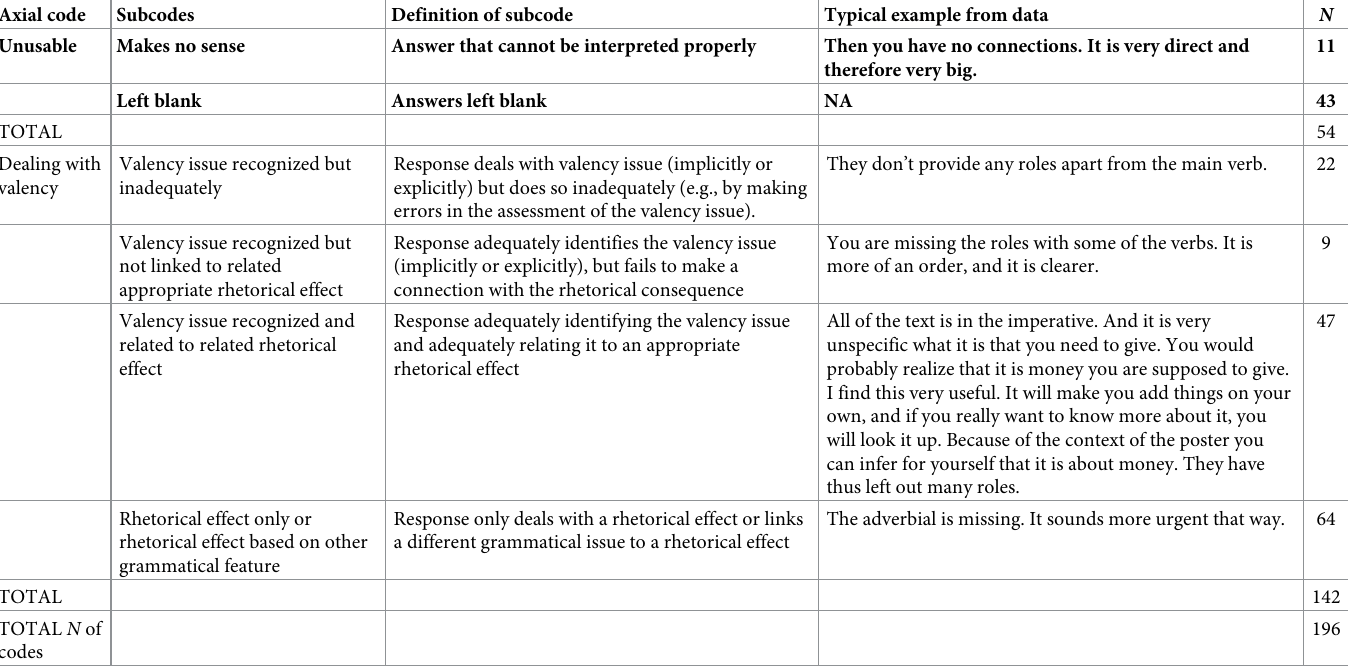
Table 6. Axial codes and subcodes related to key assignment 2 (N = 196, N = 142 performed and readable